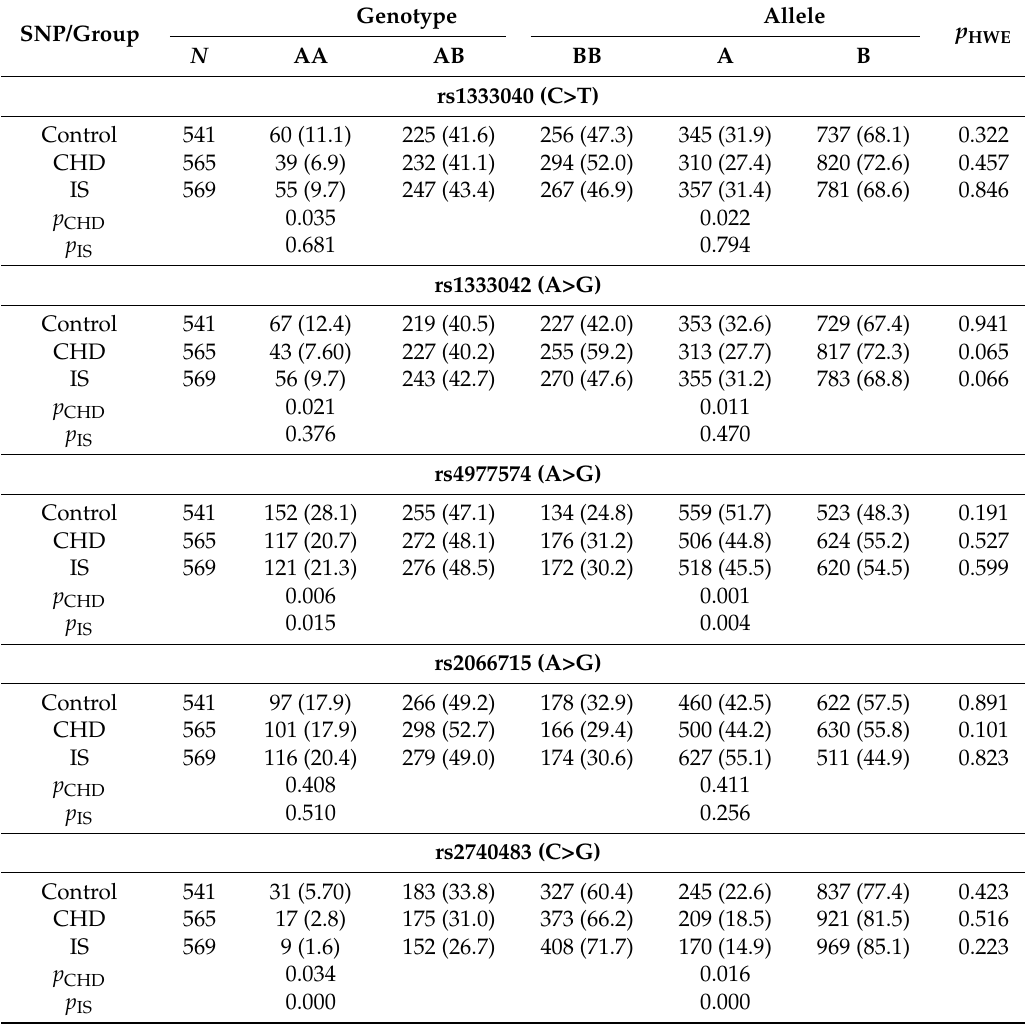
Table 2. Genotypic and allelic frequencies of the rs1333040, rs1333042, rs4977574, rs2066715 and rs2740483 SNPs in controls and patients ( n